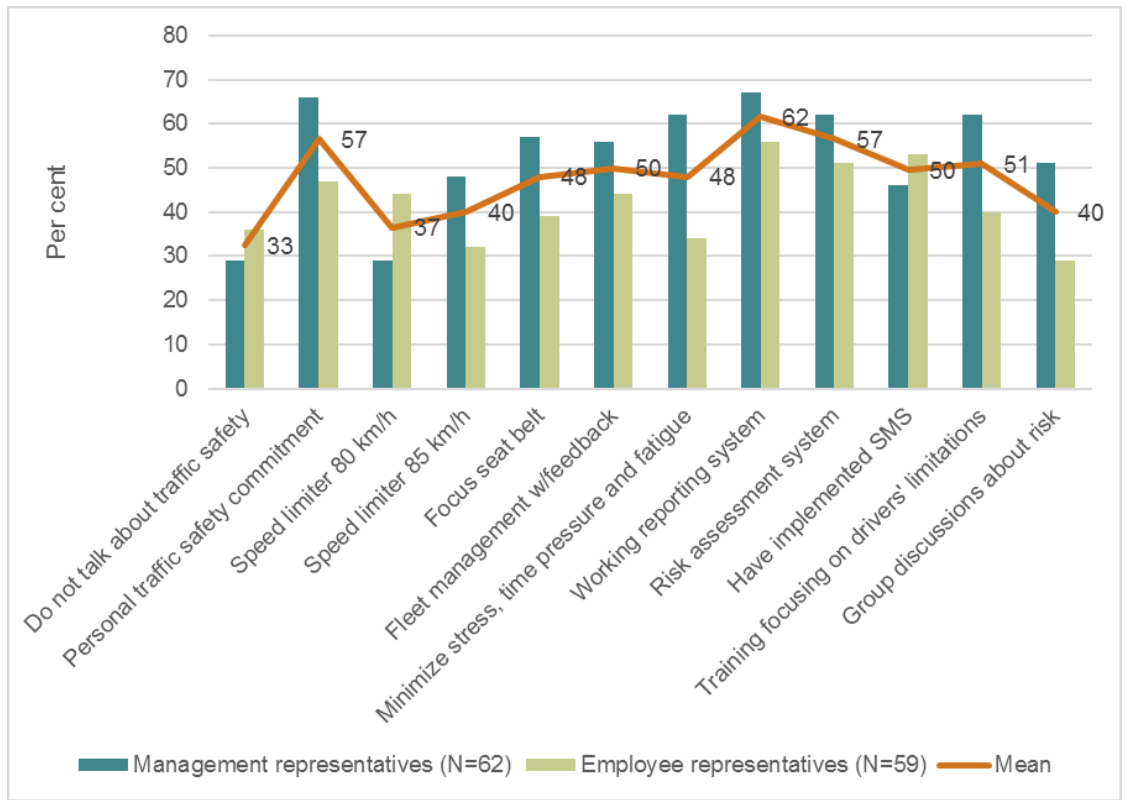
Figure 3. Results from two surveys on the occurrence of 12 OSM measures in Norwegian trucking companies.